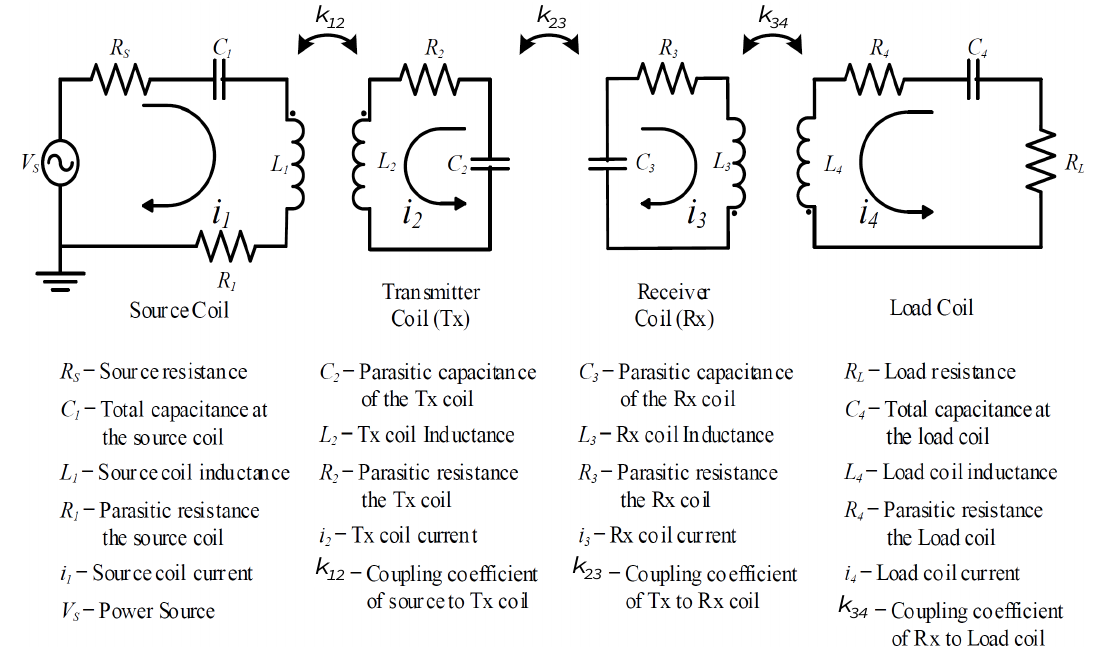
Figure 2. WPT system equivalent circuit